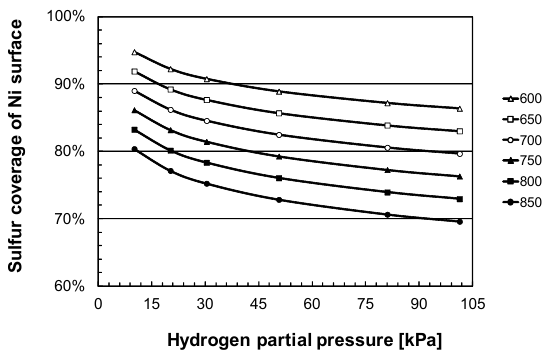
Figure 1. Sulphur coverage of the Ni surface in the H atmosphere in equilibrium at the selected temperatures (600°C – 850°C) and H S content in the fuel 2 (up to 20 ppm H S). 2